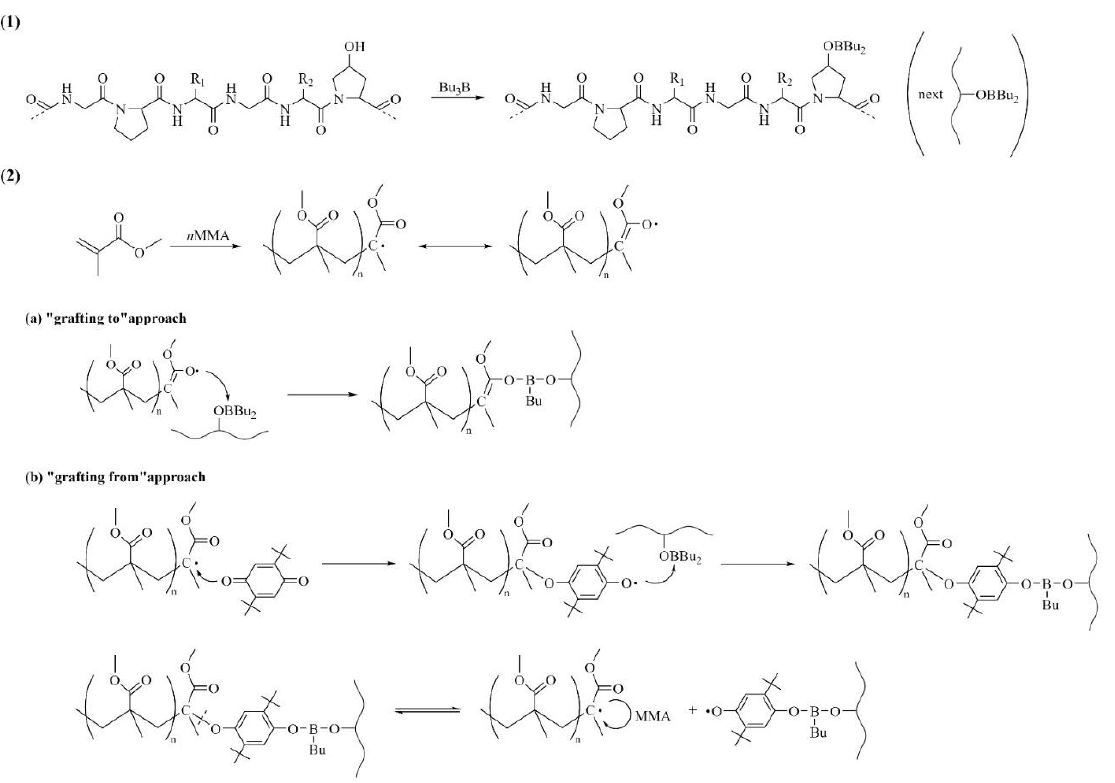
Figure 5. ( 1 ) Boration of gelatin; ( 2 ) formation of graft Gel-PMMA copolymer in the presence of ( 2a ) AIBN and TBB; ( 2b ) AIBN, TBB, and